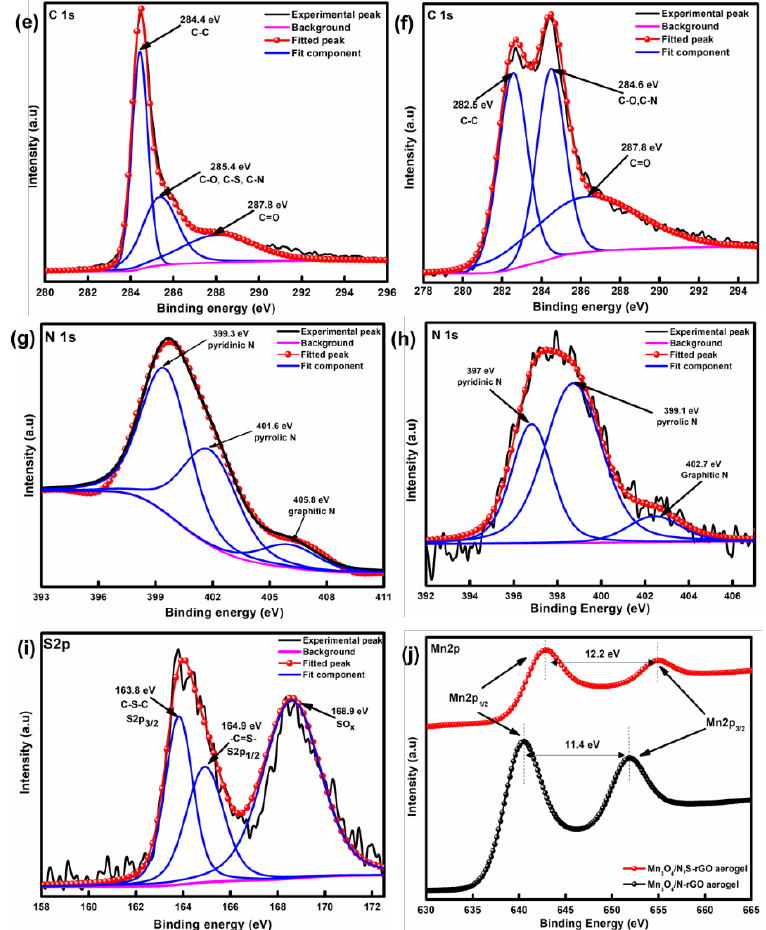
Figure 7. XPS spectra for the survey spectrum of ( a ) Mn 3 O 4 /N,S-rGO aerogel and ( b ) Mn 3 O 4 /N-rGO aerogel, O 1s spectra of ( c ) Mn 3 O 4 /N,S-rGO aerogel and ( d ) Mn 3 O 4 /N-rGO aerogel, C 1s spectra of ( e ) Mn 3 O 4 /N,S-rGO aerogel and ( f ) Mn 3 O 4 /N-rGO aerogel, N 1s spectra of ( g ) Mn 3 O 4 /N,S-rGO aerogel and ( h ) Mn 3 O 4 /N-rGO aerogel, ( i ) S 2p spectra of Mn 3 O 4 /N-rGO aerogel and Mn 3 O 4 /N,S-rGO aerogel and ( j ) deconvoluted spectra of Mn 2p of Mn 3 O 4 /N-rGO aerogel. To evaluate the sodium storage performances of the samples, the CV and galvanostatic charge/discharge testing have been conducted in a half-cell within the potential range of 0.01–3.00 V. As can be seen from Figure 8a, all samples exhibit a strong cathodic peak at 0.85 V in the first cycle and could be ascribed to the reductions of Mn 3 O 4 to MnO as well as the formation of Na 2 O, which is attributed to the decomposition of the electrolyte according to Equation